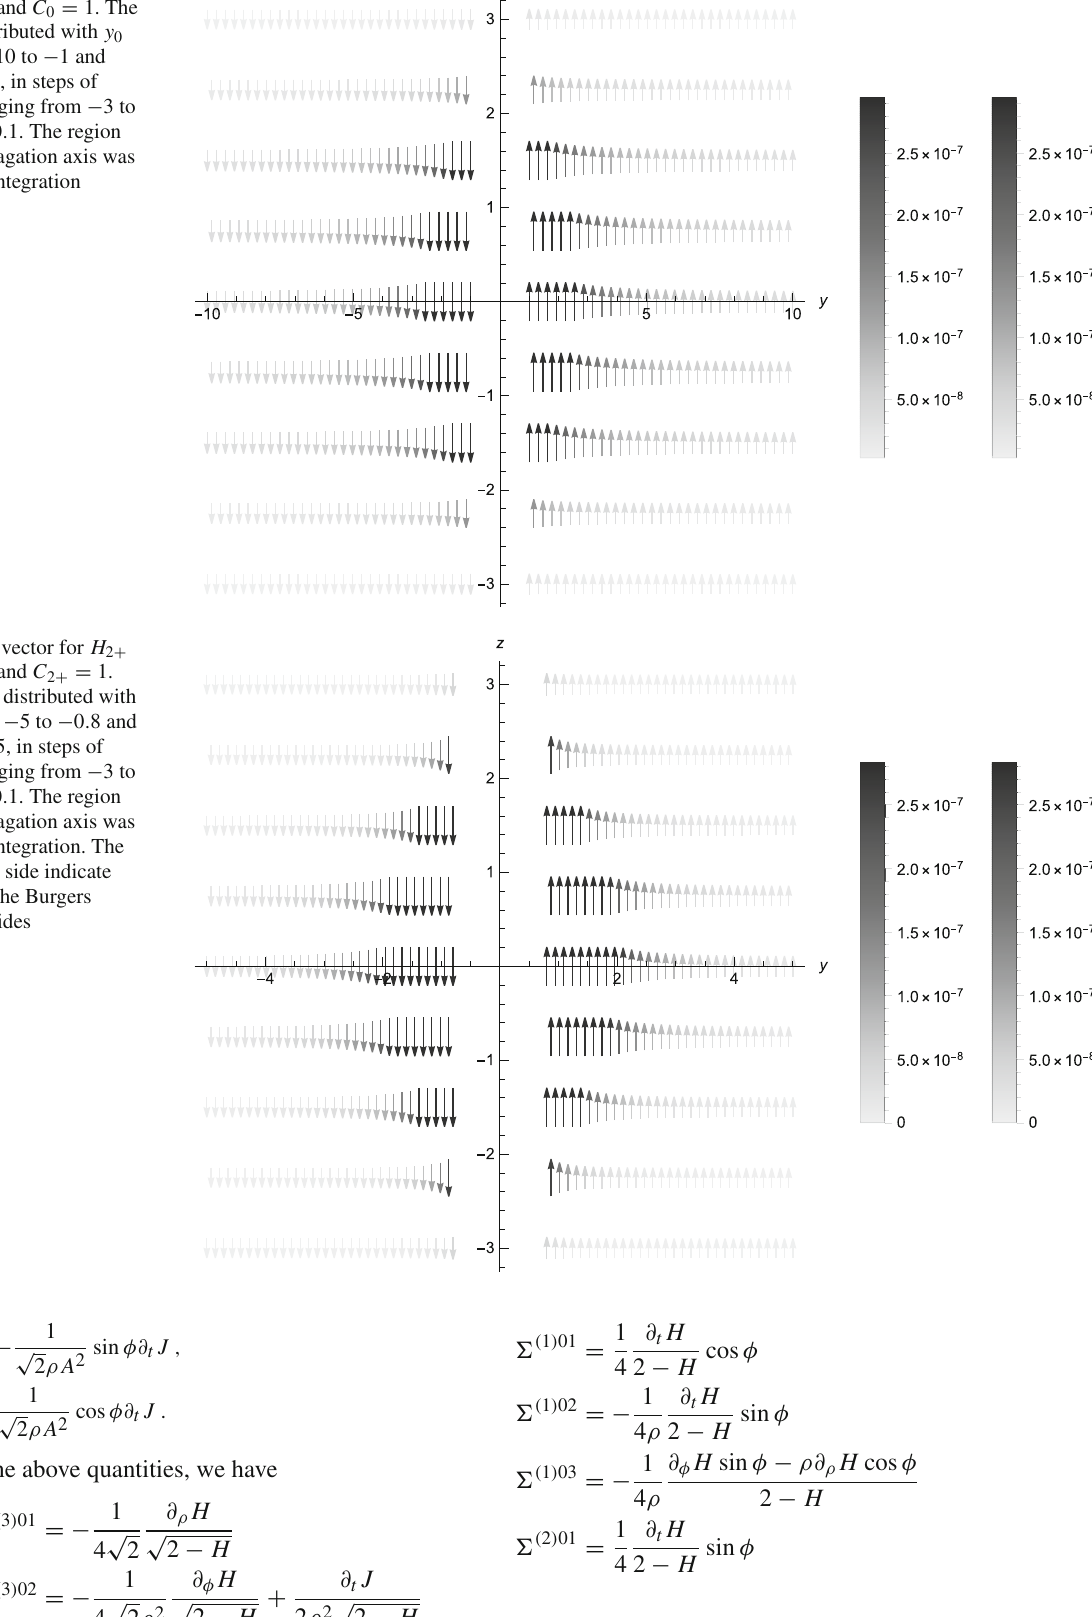
Fig. 2 Burgers vector for H 2 + with t = x = 0 and C 2 + = 1. The points were distributed with y 0 ranging from − 5 to − 0 . 8 and from + 0 . 8 to + 5, in steps of 0 . 05; and z 0 ranging from − 3 to + 3, in steps of 0 . 1. The region around the propagation axis was excluded from integration. The bars on the right side indicate the modulus of the Burgers vector on both